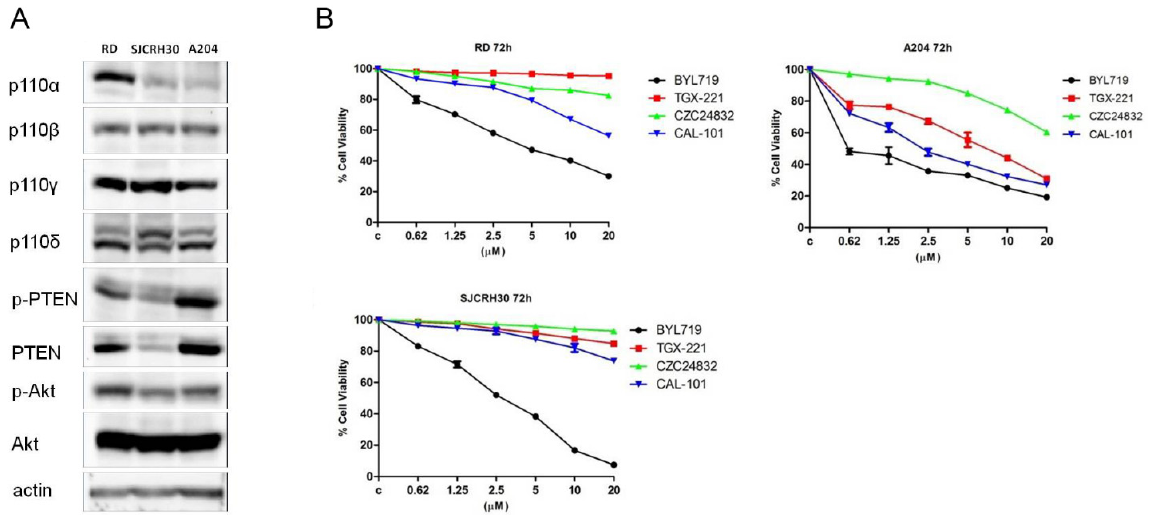
Figure 2. Alpelisib (BYL-719) and Idelalisib (CAL-101) decrease the viability of rhabdomyosarcoma cell lines. ( A ) Western blot analysis of rhabdomyosarcoma cell lines to detect the expression levels of class I PI3K isozymes; 60 µ g of protein was blotted in each lane. Antibody to β -actin served as a loading control. ( B ) MTT assay after 72 h treatment with increasing concentrations of BYL-719, TGX-221, CZC24832, and CAL-101. Three replicates per tested concentration and at least three independent experiments were performed (bars, s.d.).